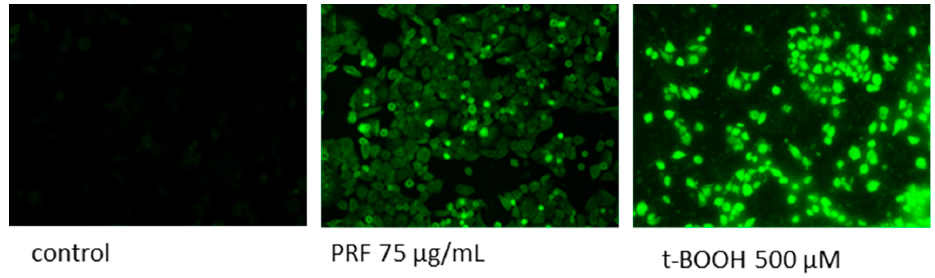
Figure 7. Intracellular ROS generation in cells after staining with DCFH-DA; cells were treated with PRF-phenolic rich fraction for 24 h; low fluorescence in control cells, very high fluorescence in positive control cells after incubation with 500 μ M t-BOOH; fluorescence microscopy (Nikon TS100 Eclipse, Japan), 200× magnification. Images are representative of one of three similar experiments.